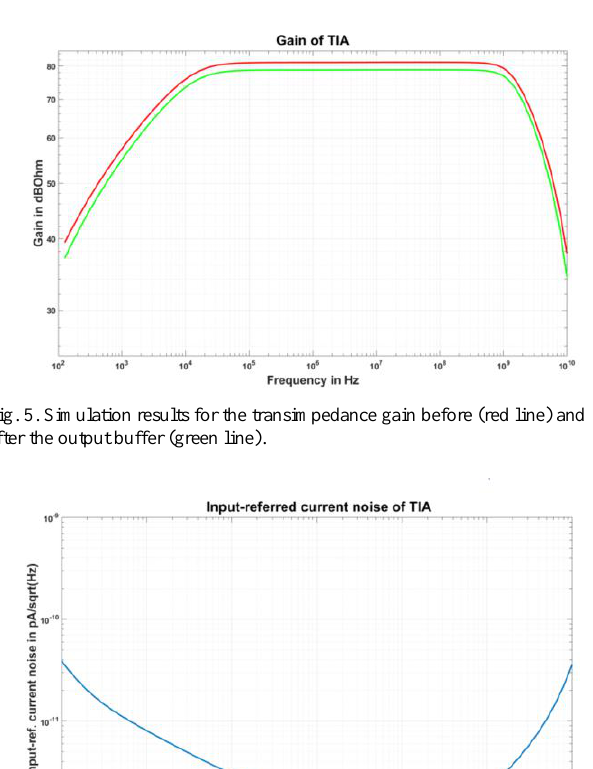
Fig. 4. Layout of the implemented TIA.